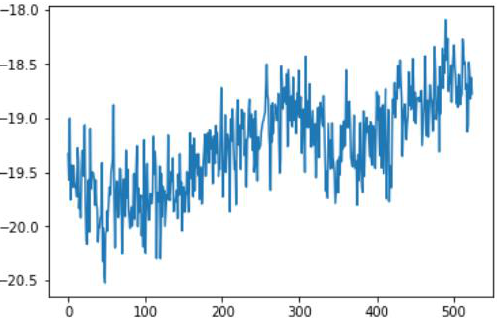
Figure 22. Merged magnetometer sensor data ( z -axis; CCIS/KSU).